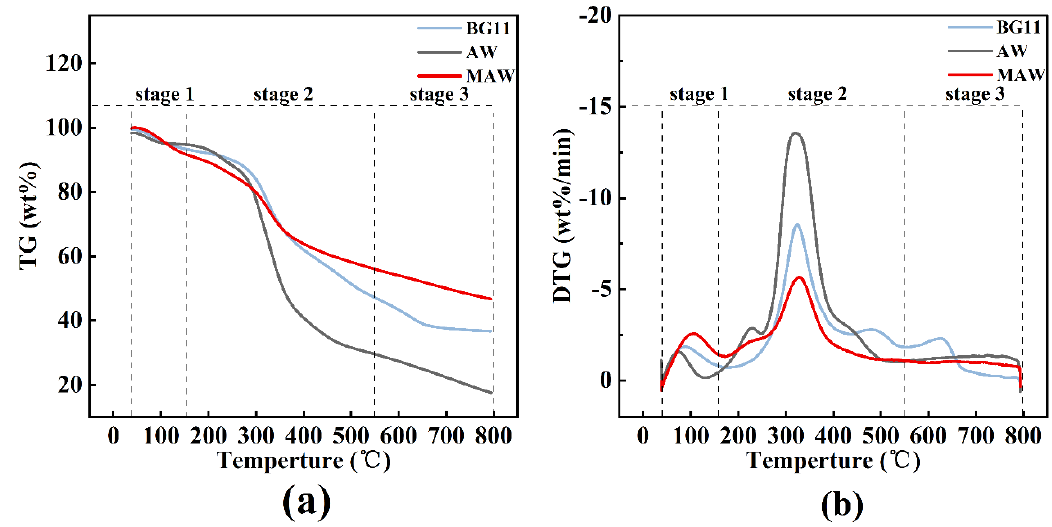
Table 1. Elemental analyses and the higher heating values (HHV) of microalgae biomass cultivated in BG11, AW and MAW media.